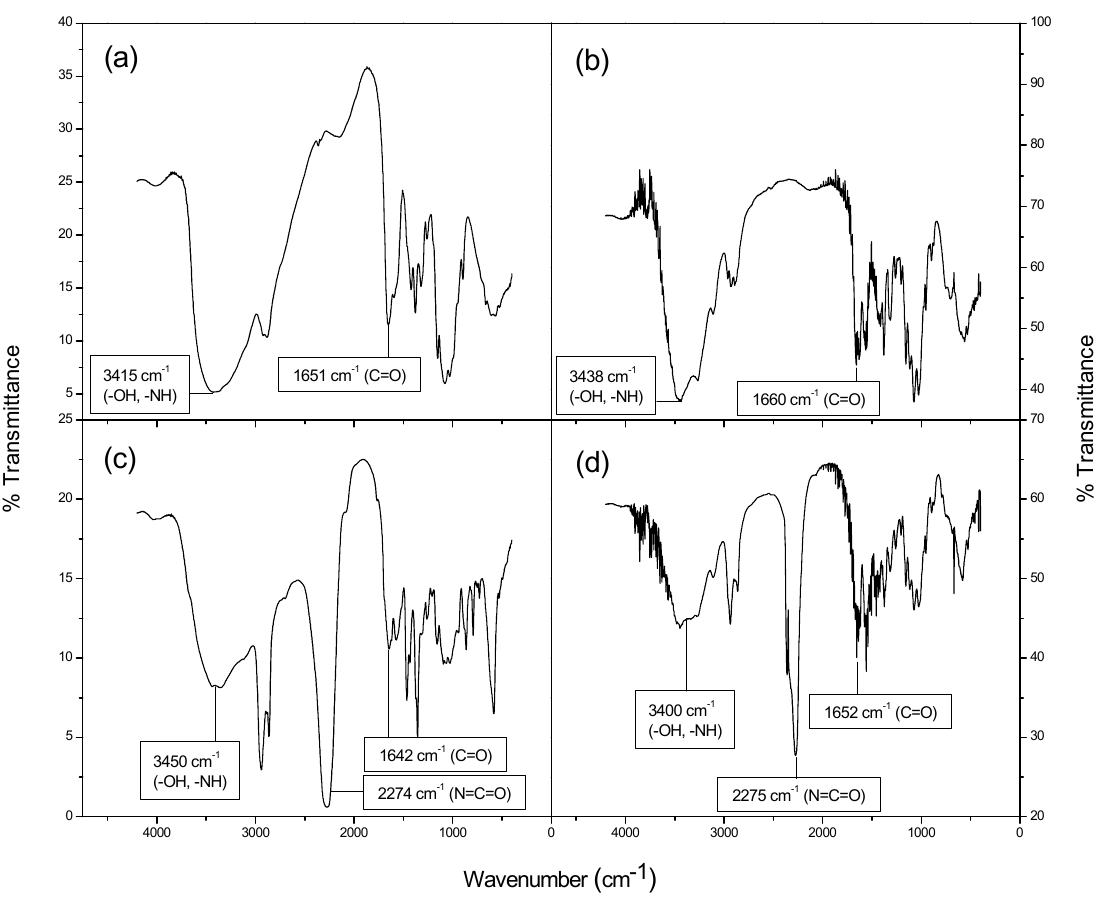
Figure 3. FTIR spectra for ( a ) chitosan, ( b ) chitin and polymers, ( c ) CSAN-2 and ( d ) CTIN-1.